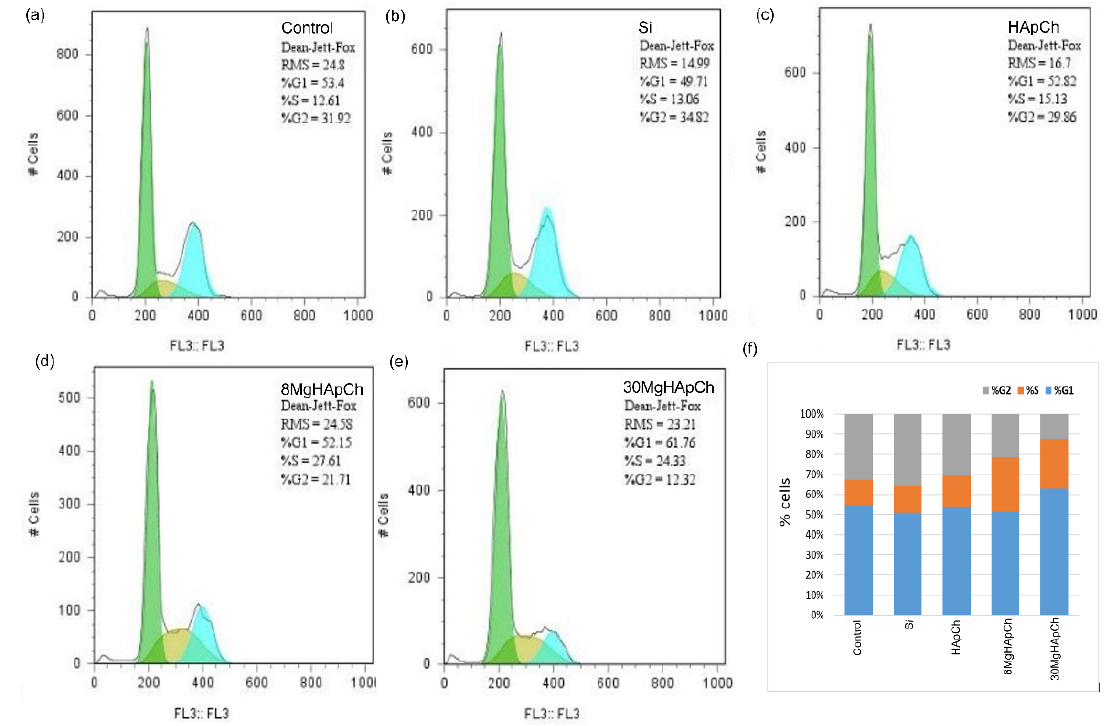
Figure 7. Flow cytometry analysis of MG63 cells grown in the presence of different substrates. Control ( a ), Si ( b ), HApCh ( c ), 8MgHApCh ( d ), 30MgHApCh ( e ) (G1-green, S-yellow, G2-blue) and graphical representation of MG63 cell cycle parameters ( f ).